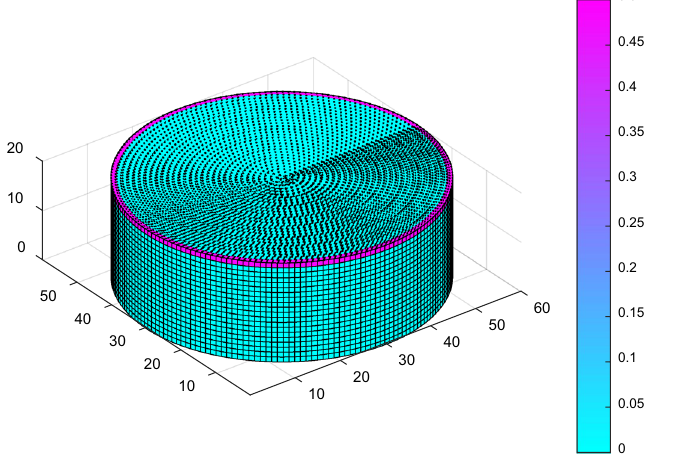
Figure 17. Lightning strike probability to a FRT of 60 m in diameter.